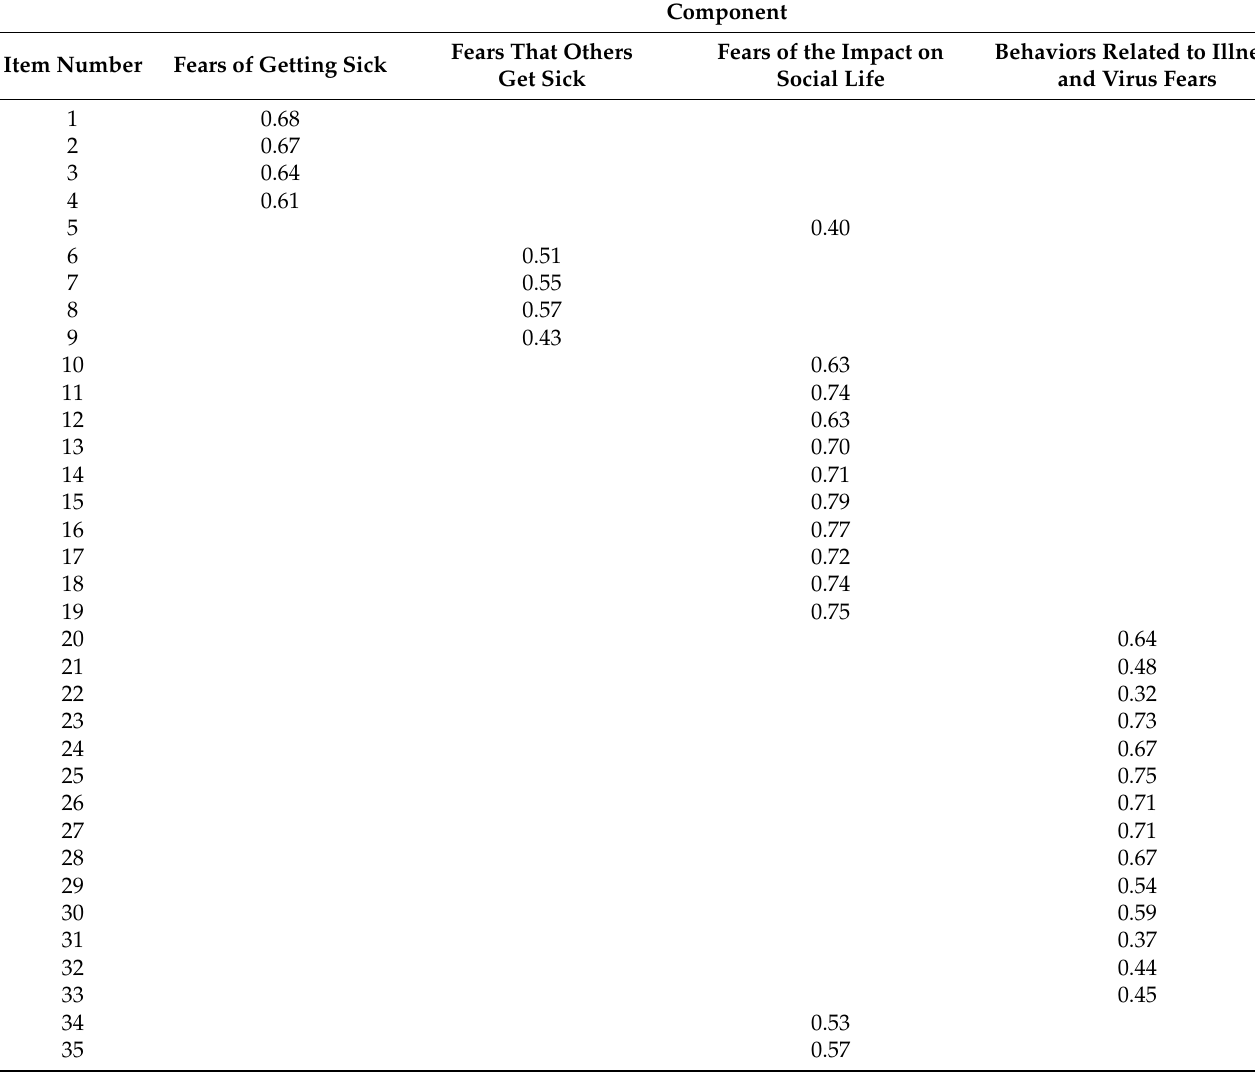
Standardized regression weights, correlation between latent factors and residual